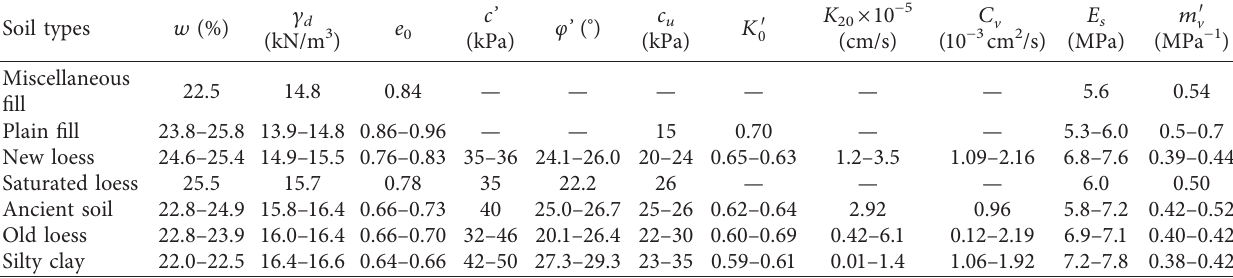
Table 1: Physical and mechanics parameters of the tunnel’s surrounding